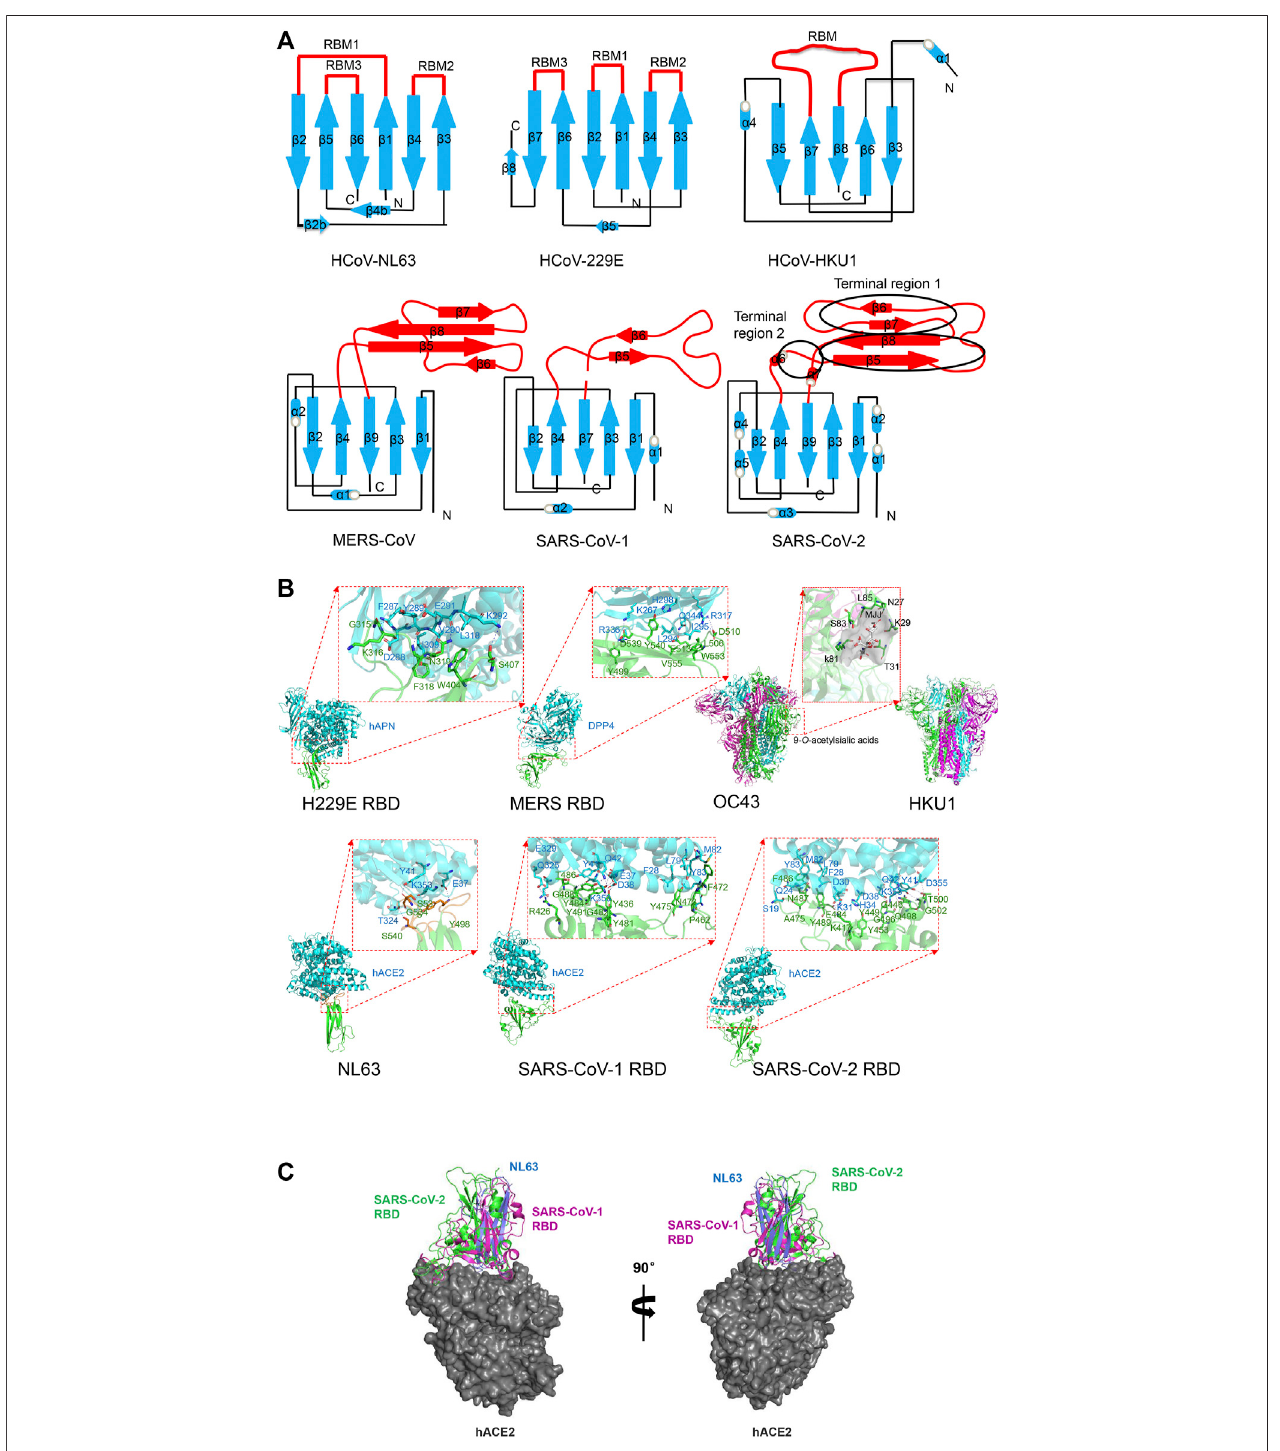
FIGURE 2 | Structure of human coronavirus spike RBD – receptor complexes. (A) Schematic of the overall structure of human coronavirus spike RBD monomer. Receptor-binding subdomain and core subdomain are indicated in red and blue color, respectively. (B) Cartoon representation of human coronavirus RBD complexes with their primary receptors. 229E with hAPN (PDB code: 6ATK) (Wong et al., 2017). MERS with DPP4 (PDB code: 4L72) (Wang et al., 2013). Residues K267, H298, R336,R317,andQ344onblade4andblade5ofDPP4interactwithD510,E536,D537,andD539residuesonMERSRBDwithhydrogenbondsorsaltbridges.A hydrophobic core is formed between Leu294 and Ile295 of DPP4 and Leu506 and V555 of MERS RBD. OC43 with 9- O -acetylsialic acids (PDB code: 6NZK) (Tortorici et al., 2019). HKU1 (PDB code: 5I08) (Kirchdoerfer et al., 2016). 9- O -Acetylsialic acids and the surface of binding cave of two hydrophobic pockets are colored in gray.